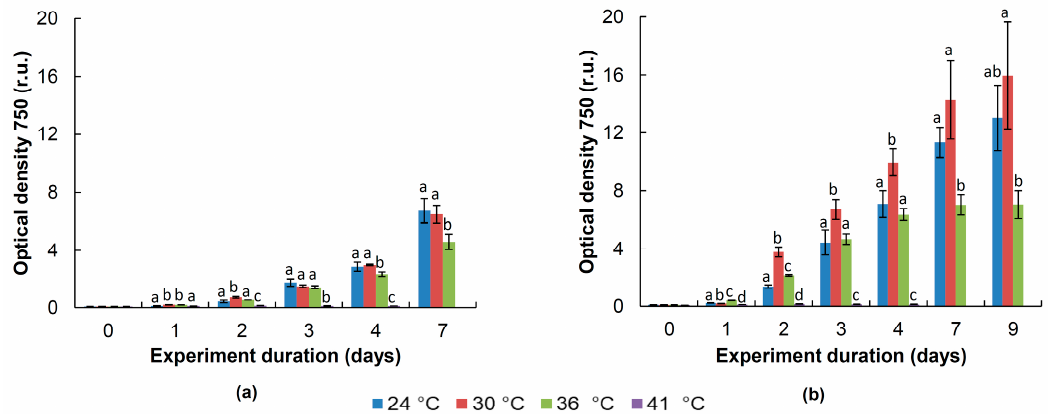
Figure 6. Growth curves of Neochlorella semenenkoi IPPAS C-1210 at different temperatures under 100 ( a ) and 500 ( b ) µmol photons m − 2 s − 1 . The error bars show standard deviations of the mean ( n = 3). The temperature variants with the same letter are not significantly different (one-way ANOVA analysis, post hoc Tukey HSD test; p < 0.05).